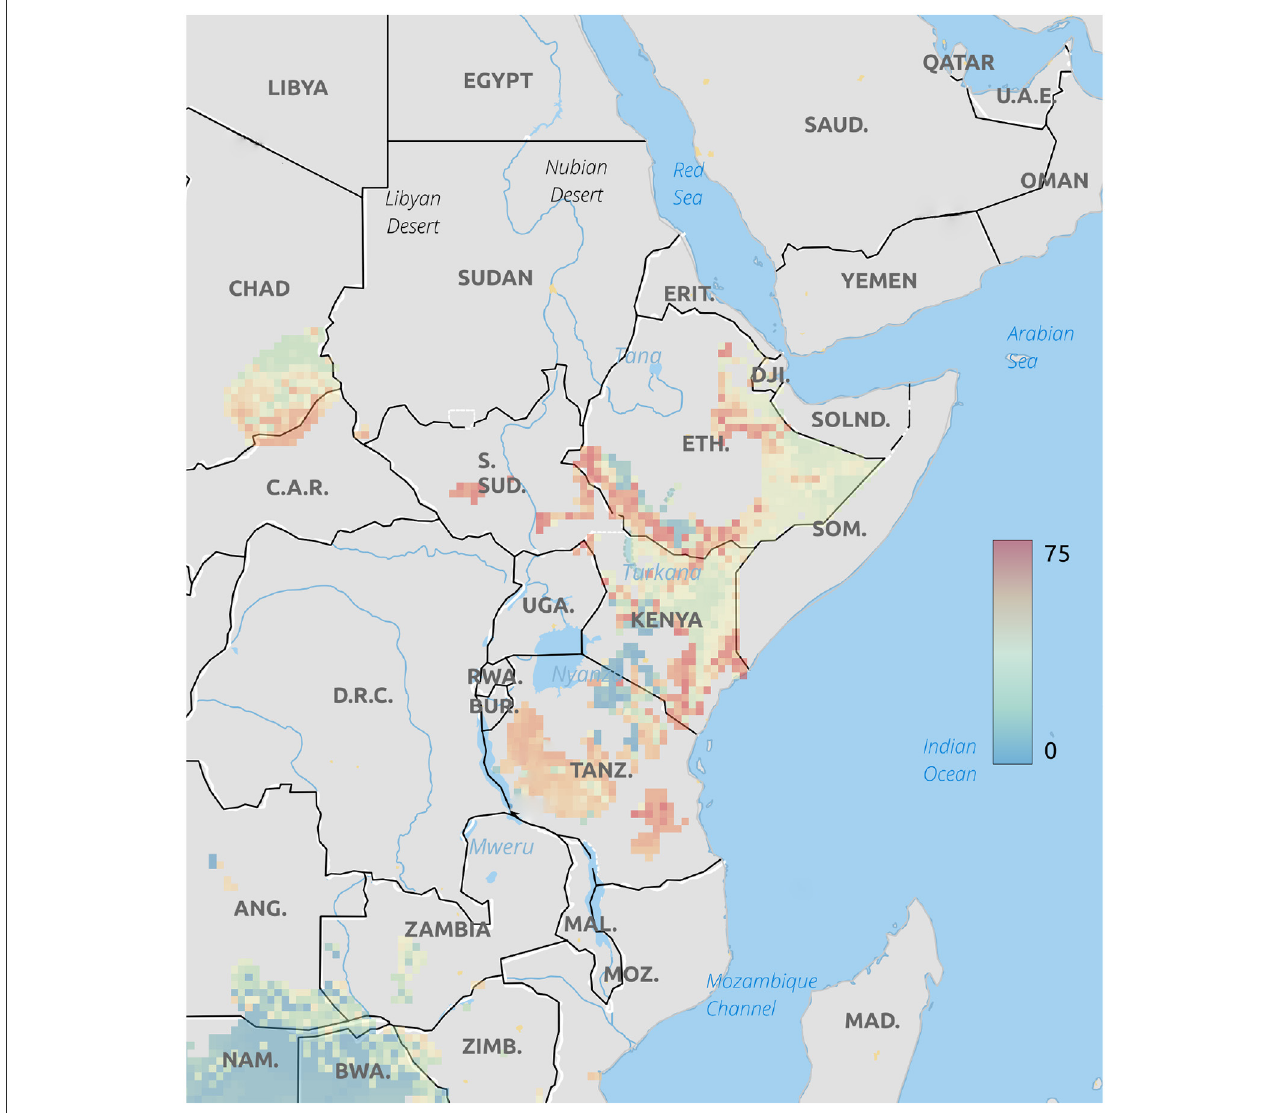
FIGURE5 Multivariate isotope assignment of cheetah cubs to location based on a δ 18 Oand δ 13 Cvalues. Legend is the number of individuals assigned to a pixel based on the odds ratio criterion used.